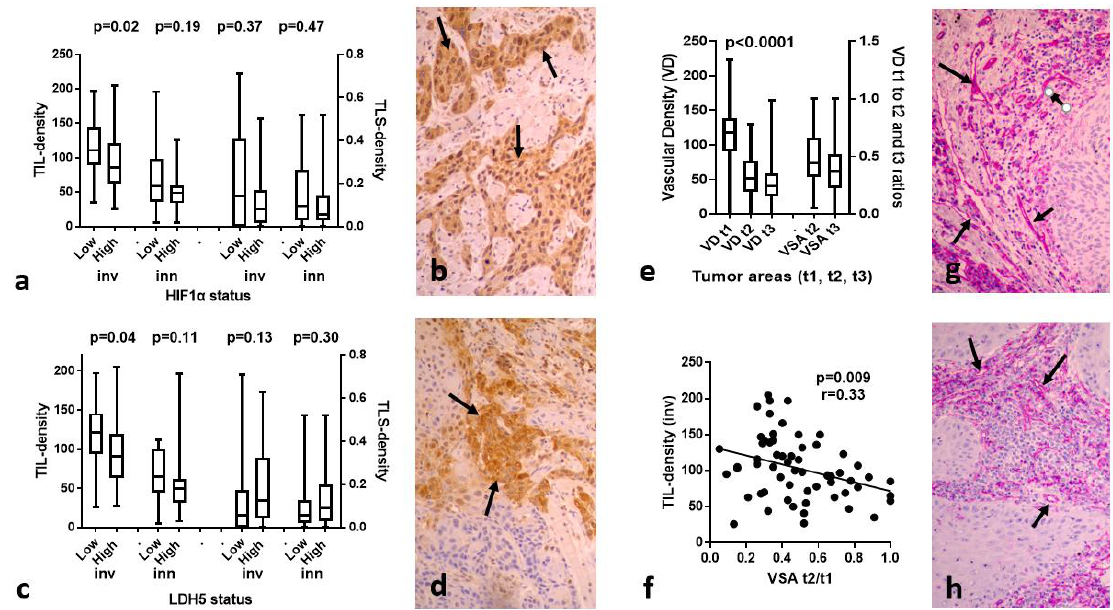
Figure 2. TIL, TLS densities, and hypoxia/angiogenesis variables. Box and whiskers show the median, range and 25th/75th percentiles: ( a ) TIL and TLS density in the invading front and inner tumor areas according to HIF1 α expression status; ( b ) Typical immunohistochemical image of a lip carcinoma with high nuclear and cytoplasmic HIF1 α expression (arrows); ( c ) TIL and TLS density in the invading front and inner tumor areas according to LDH5 expression status; ( d ) Typical immunohistochemical image of a lip carcinoma with high nuclear and cytoplasmic LDH5 expression (arrows); ( e ) Vascular density (VD) and vascular survival ability (VSAt2/t1 and VSAt3/t1) in the tumor invading front (t1) and inner tumor areas (t2 and t3), as assessed with anti-CD31 moAb ( f ) Linear regression graph of TIL density in the invading tumor front vs. vascular survival ability (VSAt2/t1); ( g ) CD31 immunostaining of a lip carcinoma tissue section with high VD in the invading tumor front (t1-area) (arrows); and ( h ) t2 are of the same tumor showing sustained, still reduced, VD (arrows). All immunohistochemical images are at × 20